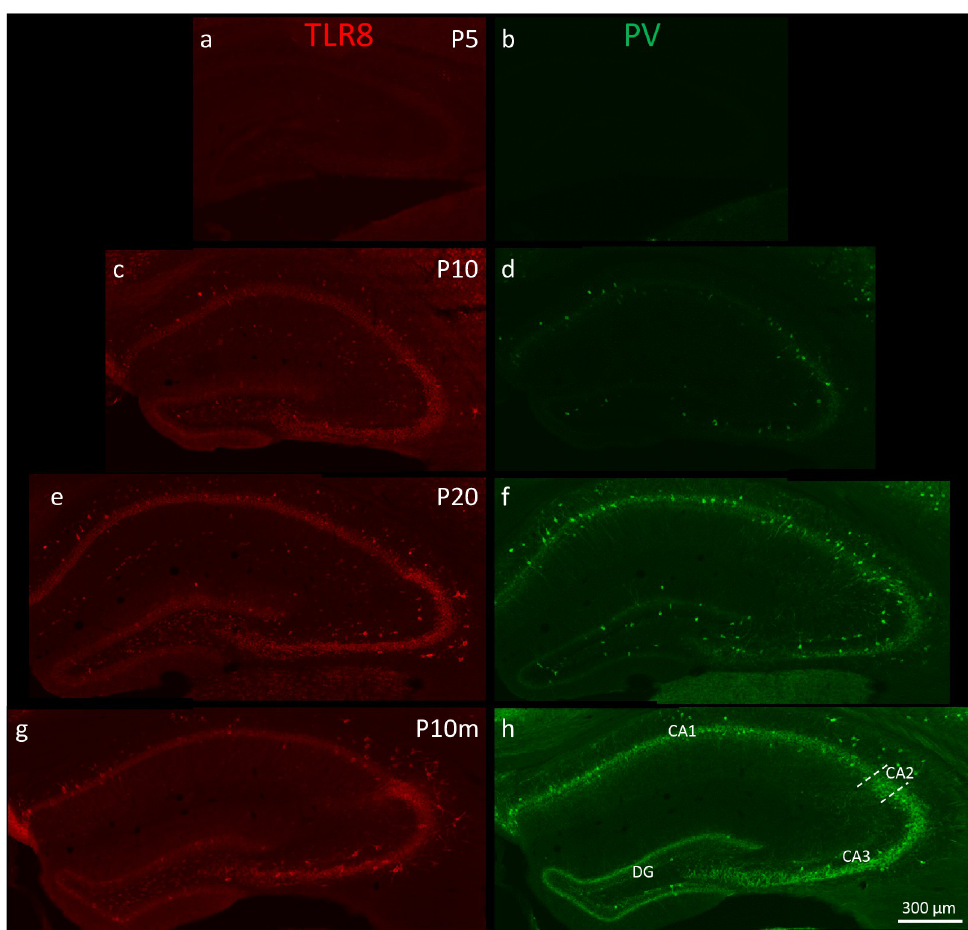
Fig 7. Time-course of postnatal expression of TLR8 and PV in the mouse hippocampus. At birth (P0), no TLR8- or PV-immunoreactivity was detected in the hippocampus (not shown). At P5, few TLR8-expressing interneurons, but no PV-expressing interneurons were visible (a, b). Numerous interneurons expressing TLR8 and/or PV were present in all subregions of the hippocampus at P10 (c, d). TLR8 was also expressed in granule cells of the dentate gyrus and in pyramidal neurons of the hippocampus proper. PV-labeling was restricted to cell bodies and neurites (dendrites; axon terminals surrounding somata of dentate granule cells and hippocampal pyramidal cells). At later time points (P20 and P10m), numerous interneurons and principal neurons expressed TLR8 (e, g). Labeling intensity of PV-interneurons at these stages was stronger than in very young mice and the numbers of PV-immunoreactive interneurons was increased